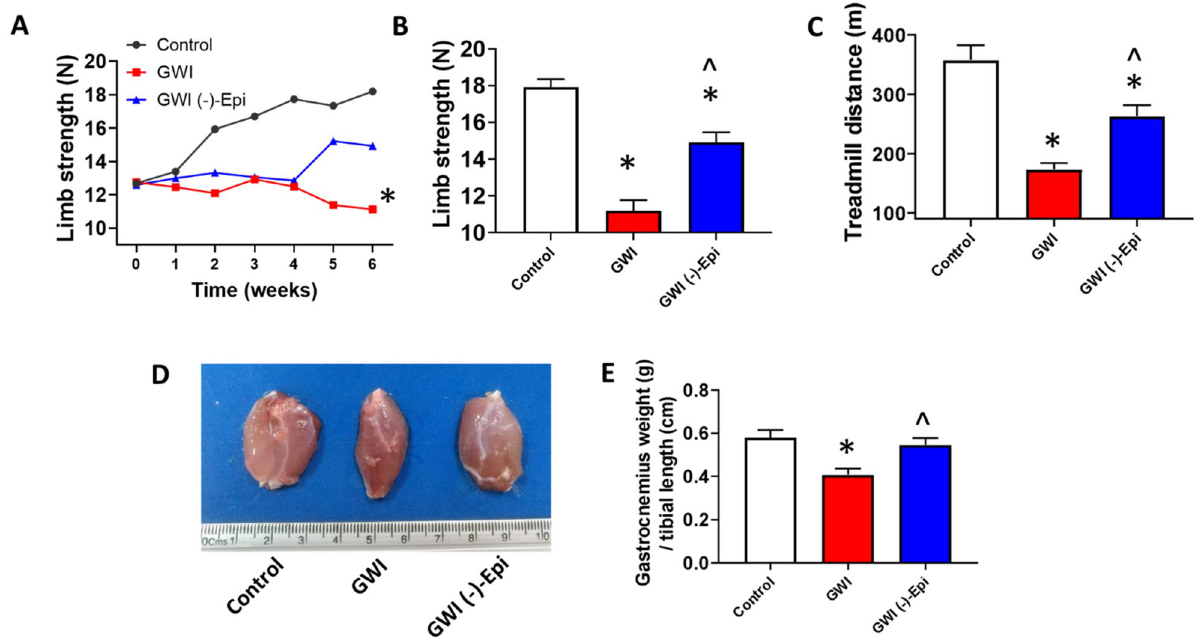
Figure 2. Restorative effects of (−)-epicatechin (Epi) on GWI rat muscle mass and function. Front limb strength recorded weekly (A) and at the final (6 week) recording (B) in control (n = 9), GWI (n = 5) and GWI- Epi (n = 5) rats. (C) Reports on the treadmill test results (time and total distance respectively). (D,E) Illustrate and report on weight recorded for gastrocnemius muscles. *p < 0.05 vs. control, ^p < 0.05 vs. GWI by ANOVA and by t-test.